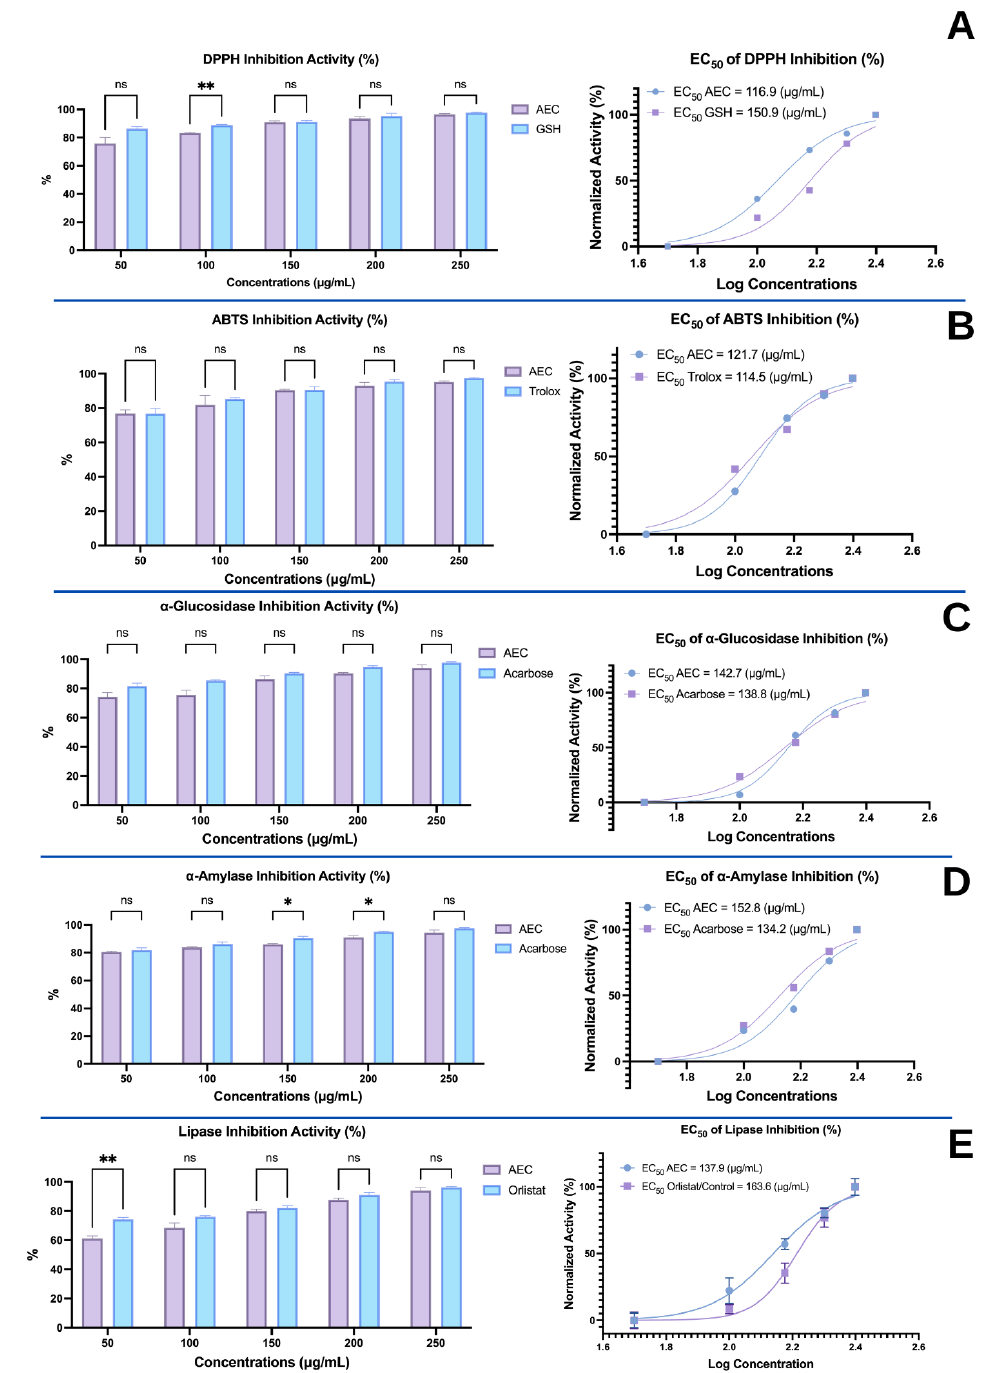
Figure 1. In vitro activities of the aqueous extract of Caulerpa racemosa (AEC). ( A ) DPPH radical- scavenging activity. ( B ) ABTS radical-scavenging activity. ( C ) Inhibition of the α -glucosidase enzyme. ( D ) Inhibition of the α -amylase enzyme. ( E ) Inhibition of the lipase activity; ns: p = 0.1638 ( p > 0.05); * : p = 0.0125; ** : p = 0.0007. Note: The EC 50 was analyzed using the GraphPad Premium statistical analysis package “non-linear regression (log(inhibitor) vs. normalized response—variable slope”. The plot bars showed that at a concentration of 50 µ g/mL, all inhibition activity exceeded 50%. This may be caused by the unequal maximum and baseline effects of AEC compared to the controls. For further research, using a lower minimum dose for the controls and a higher maximum amount of AEC may result in a comparable dose response for all compounds (EC 50